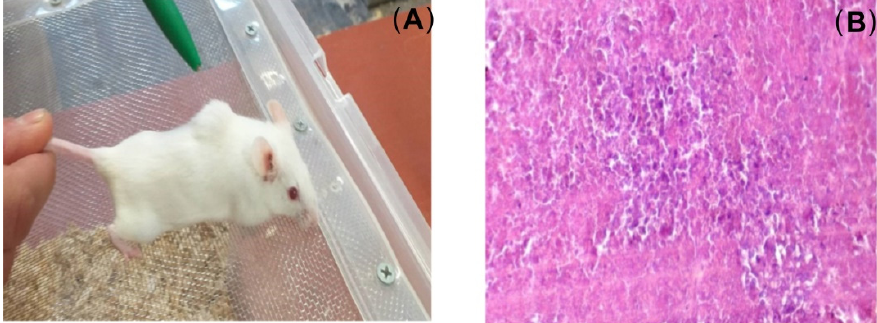
Figure 6. The appearance of a mouse with a transplanted tumor on day 24 after transplantation (Tumor size 2.5 cm) ( A ), photograph by S. Staroverov. Histological section of the tumor on day 24 after transplantation ( B ). Staining with hematoxylin − eosin, ×300.